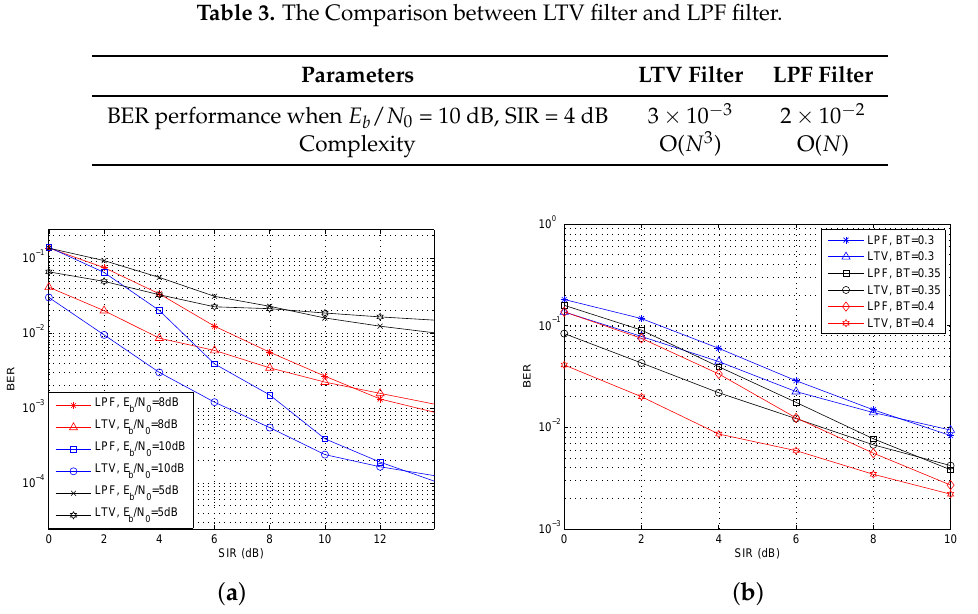
Table 3. The Comparison between LTV filter and LPF filter.